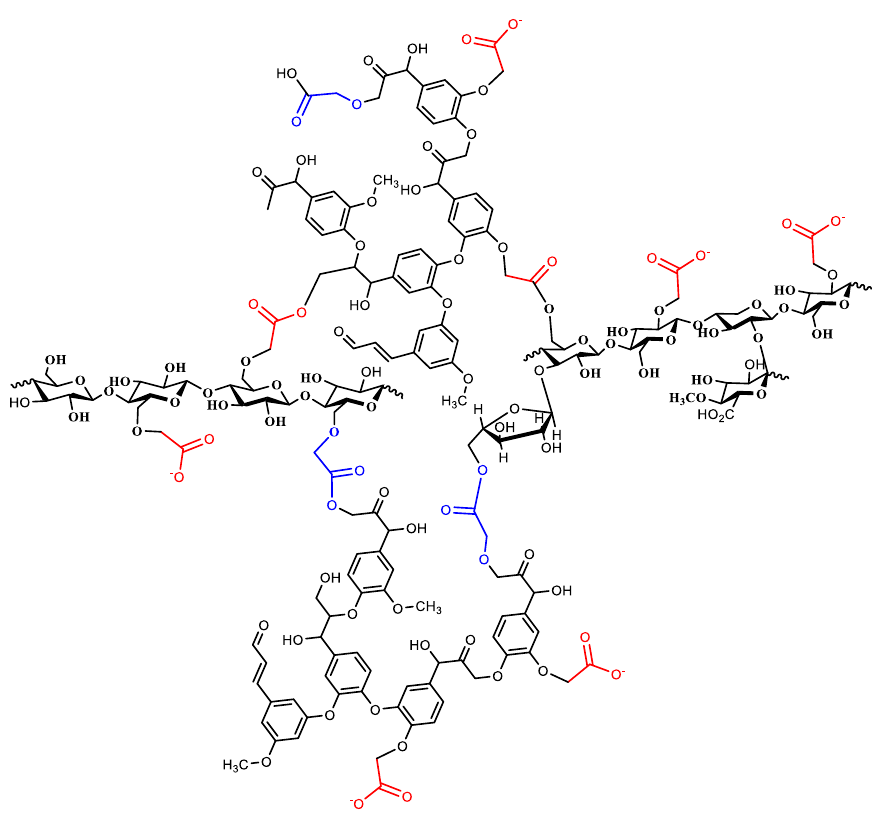
Figure 3. A representative figure of the cured (crosslinked) CMOISW.